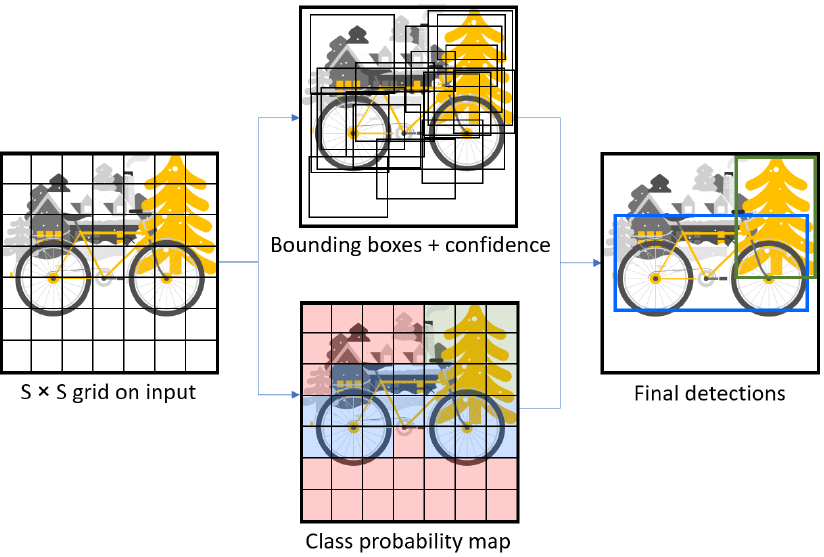
Figure 4. Final stage in the YOLOv5 network